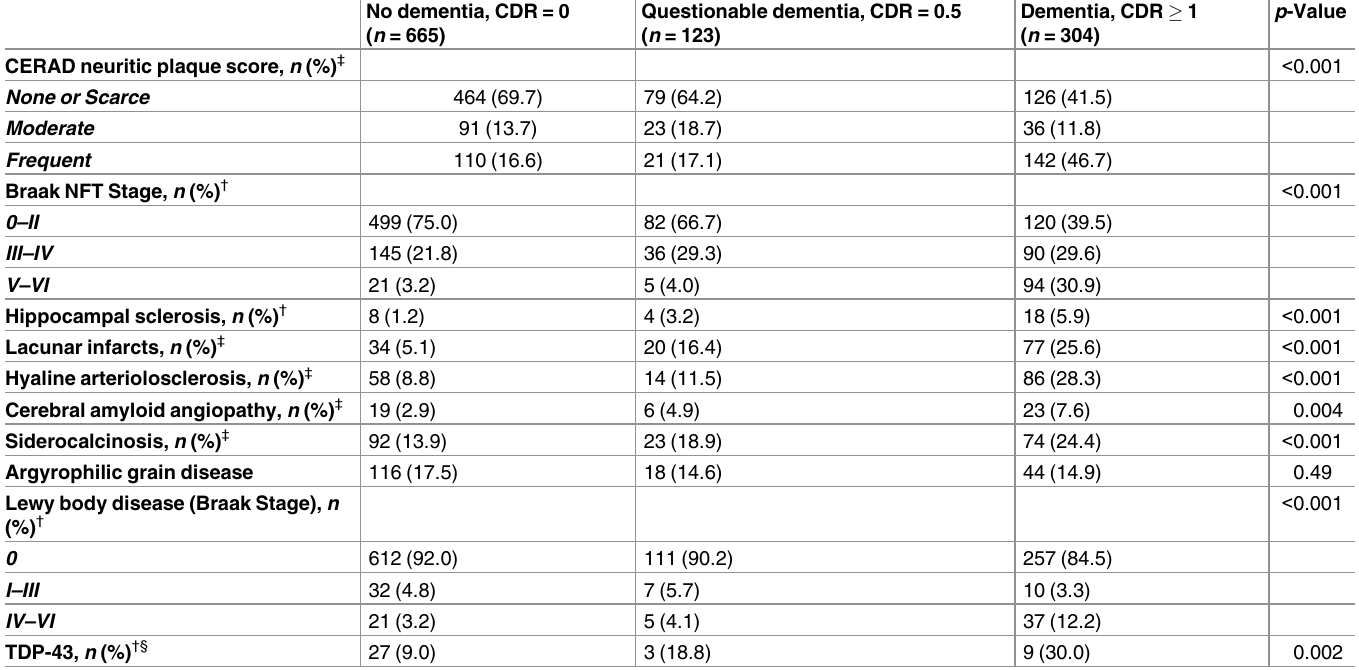
Table 2. Frequency of neuropathological lesions per dementia status ( n = 1,092).